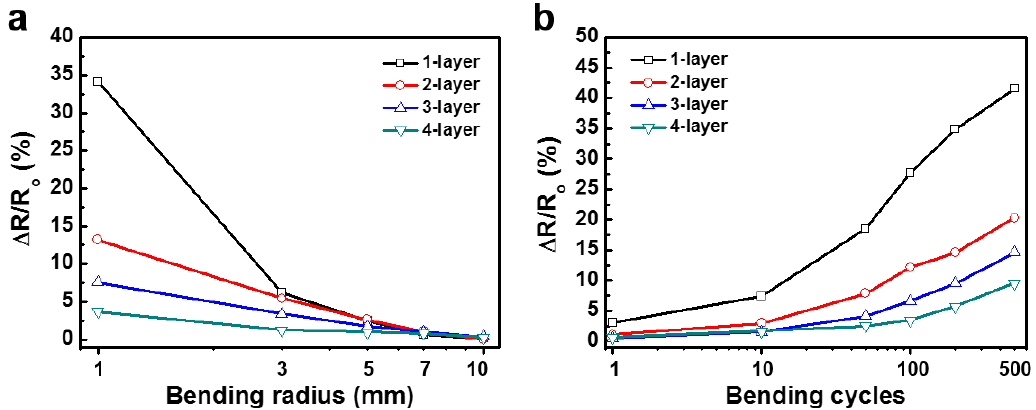
Figure 4. Variations in the resistance of single- or multi-layered MMSs on a flexible substrate as a function of ( a ) bending radius; and ( b ) the number of cycles repeated under bending radius of 1 mm.